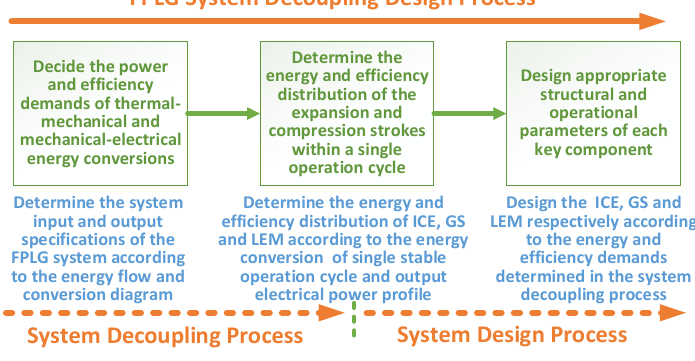
Figure 2. Proposed decoupling design process of FPLG system.